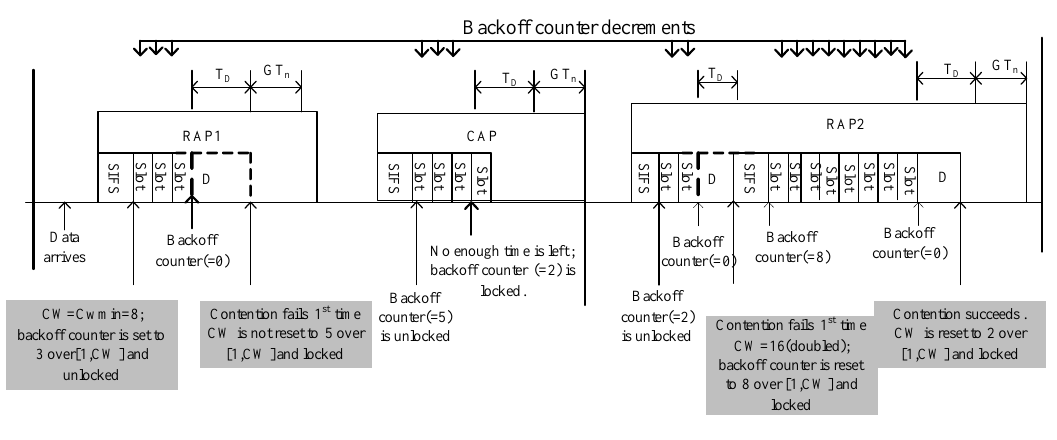
Figure 7. The IEEE 802.15.6 CSMA/CA